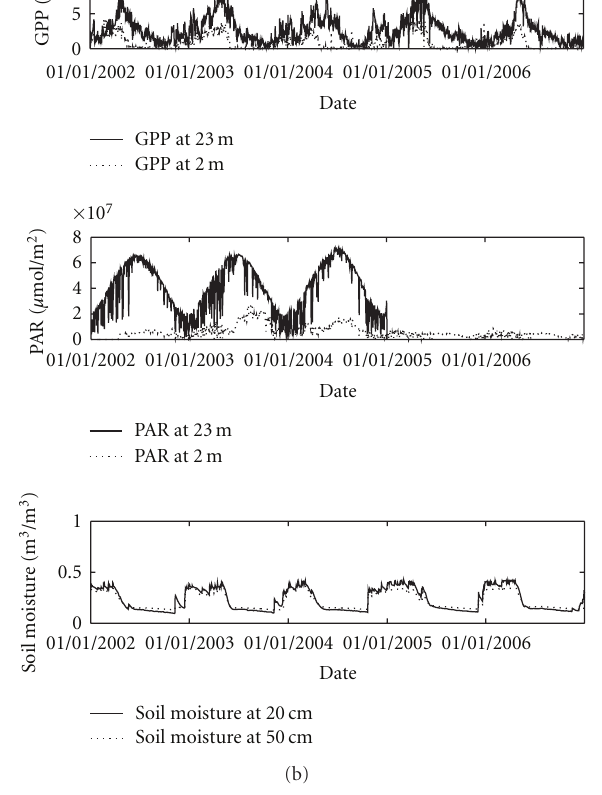
Figure 1: Time series of GPP (gC/day), PAR ( μ mol/m 2 ), and daily soil moisture (m 3 /m 3 ) at two di ff erent depths in the open grassland (a) and the oak savanna